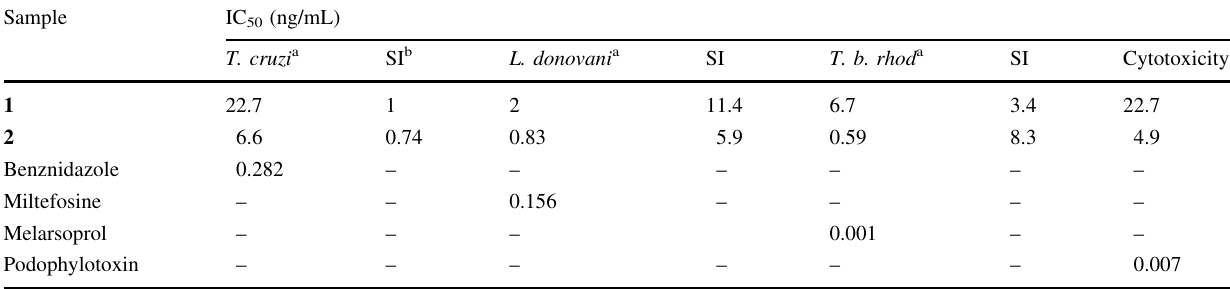
Table 4 Antitrypanosomal, antileishmanial, cytotoxicity activities of compounds 1 and 2. And calculated selective index Sample